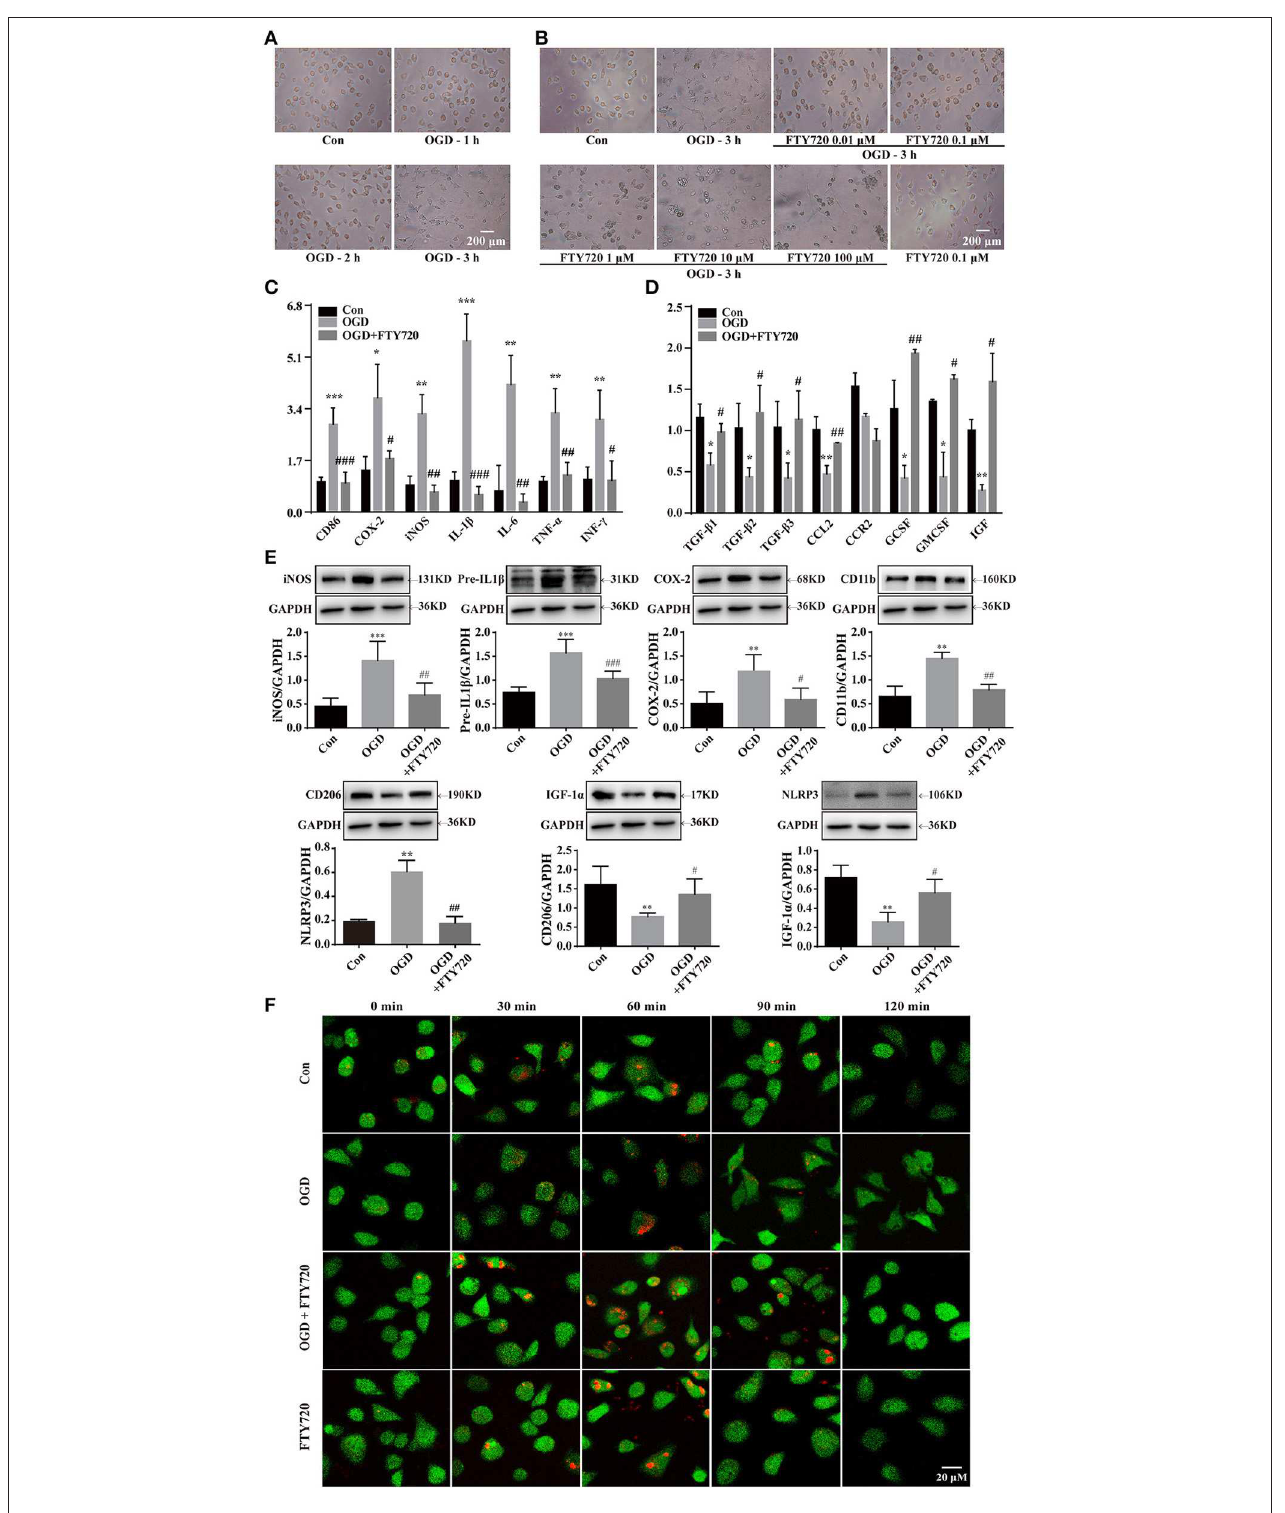
FIGURE 3 | FTY720 treatment promotes microglial phenotypic change from M1 to M2 in OGD model. OGD for 3h induced microglial cells activation which showed larger and rounder shape with slim branches compared with the control group (A) . FTY720 (0.01 µ M) suppressed the amoeboid “activated” morphology of microglia induced by3h OGD (B) . FTY720 reversed 3h OGD-induced mRNA expressions of M1 markers (CD86, COX-2, iNOS, IFN- γ , IL-1 β , TNF-a, and IL-6) (C) and mRNA